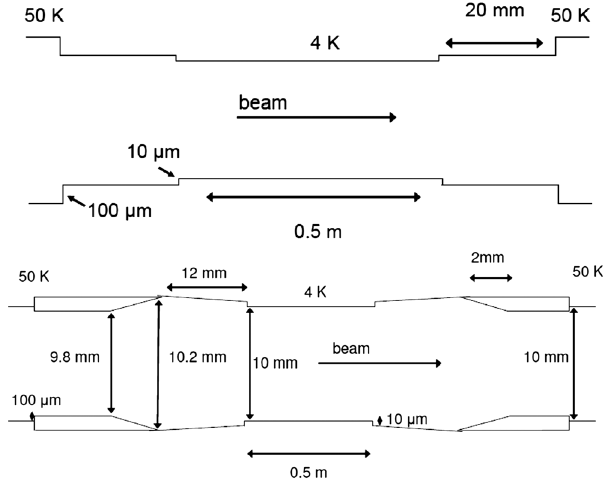
FIG. 7. Top: step transitions from the cold copper liner at 4 K to the 50 K shield made for the first installation of the COLDDIAG in the DLS. Bottom: tapered transitions from the cold copper liner at 4 K to the 50 K